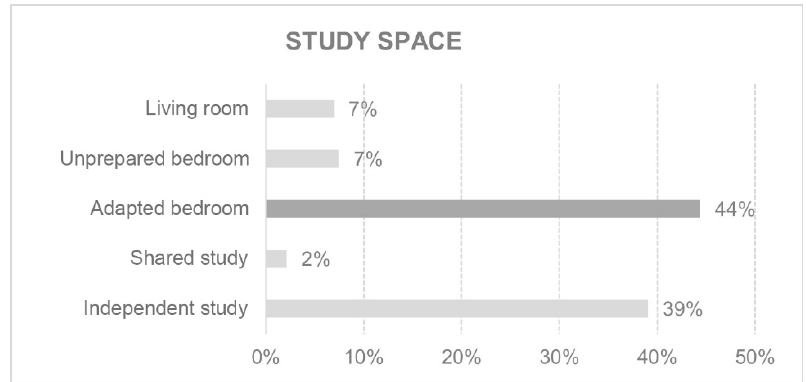
Figure 4. Hours of physical exercise per week.